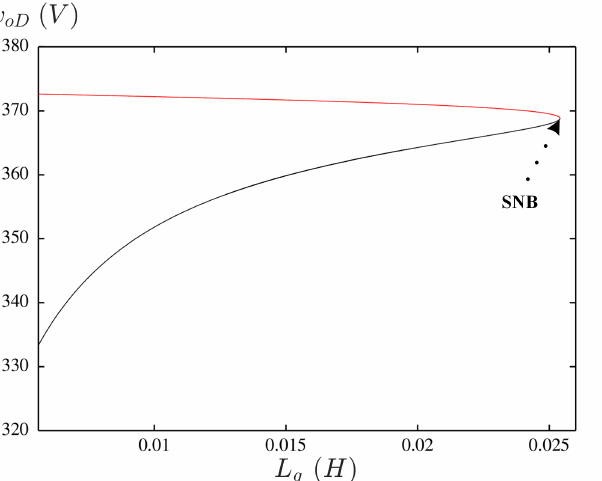
Figure 19. Bifurcation diagram by varying L g : stable solutions in red and unstable solutions in black.